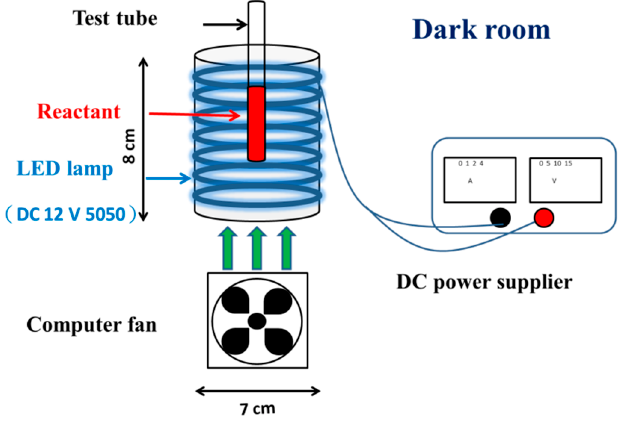
Figure 2. Experimental setup of the photoreaction system. LED: light-emitting diode.